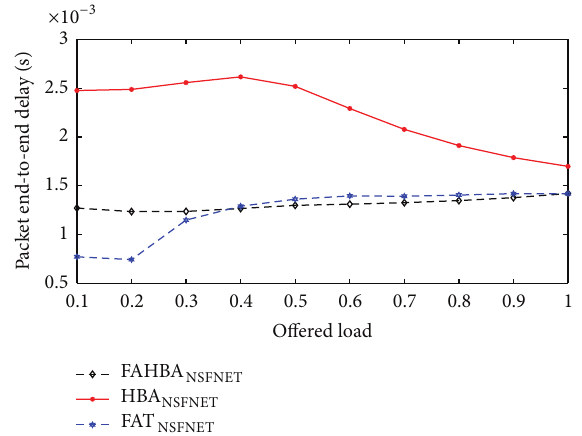
Figure 9: Packet end-to-end delay versus offered